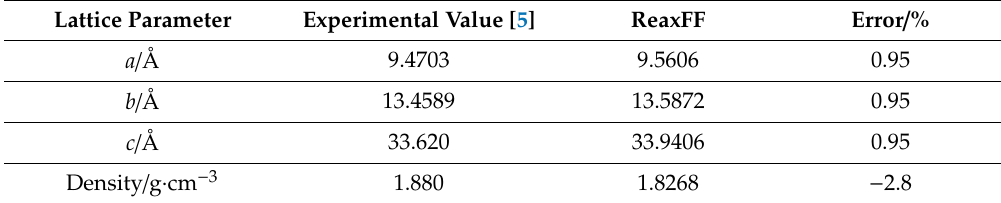
Figure 8. Differential scanning calorimetry (DSC) curves of explosive samples [20], with permission from Han Neng Cai Liao, 2015. Table 7. The lattice parameters of CL-20/DNB cocrystal were calculated by the ReaxFF force field compared with the experimental value.